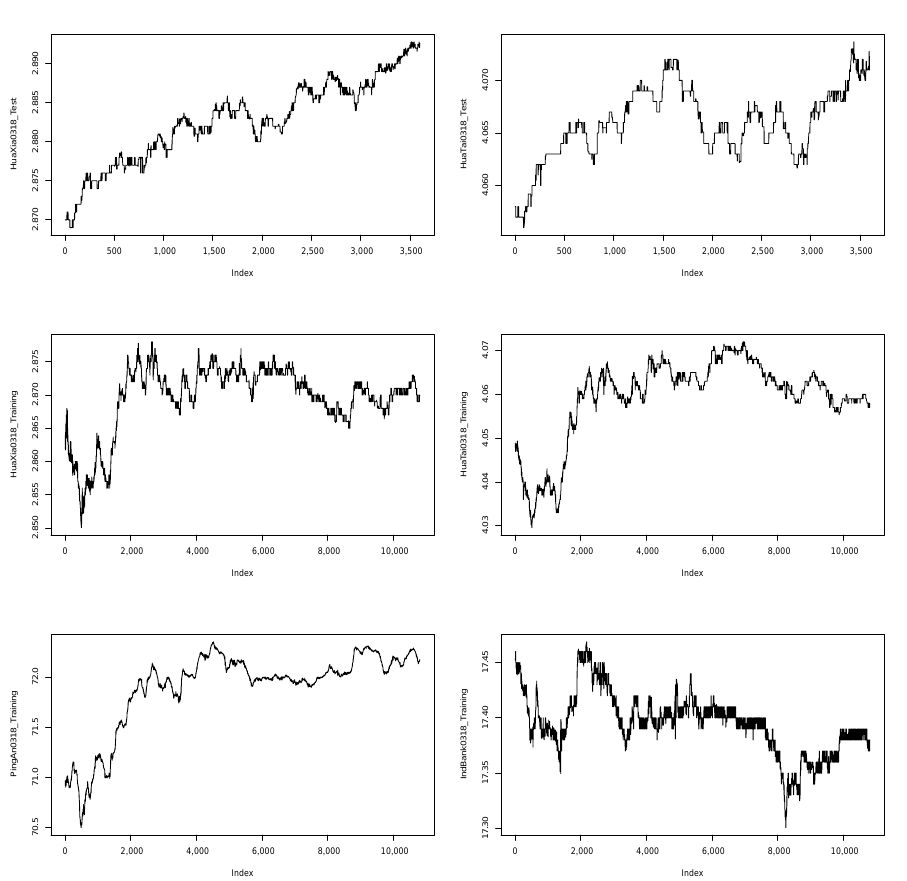
Figure 4. Case 2—Second-level HuaXia ETF and HuaTai ETF prices time series on day 1 (18 March 2018). The MGMA strategy performance summary for HuaXia ETF and HuaTai ETF on day 1